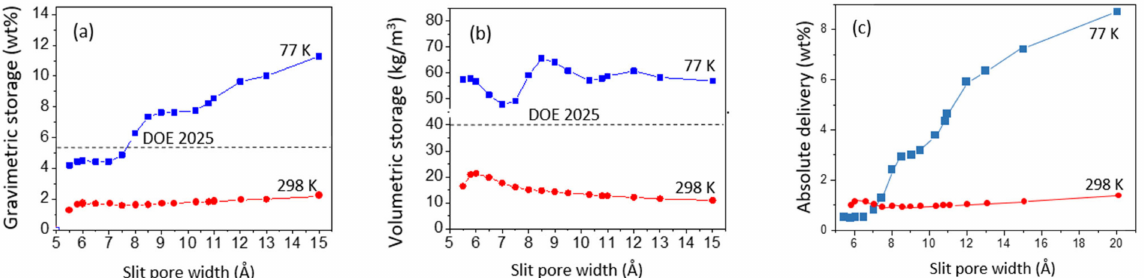
Figure 1. ( a ) The total gravimetric and ( b ) volumetric quantity of hydrogen stored in infinite carbon slit pores at T = 77 K and T = 298 K and the gas pressure of 100 bar; the dashed lines indicate the gravimetric and volumetric DOE goals for 2025 (55 gH 2 /kg of system, 40 gH 2 /L of system, respectively); ( c ) absolute hydrogen delivery during the adsorption–desorption cycle between 1 and 50 bar, as a function of pore